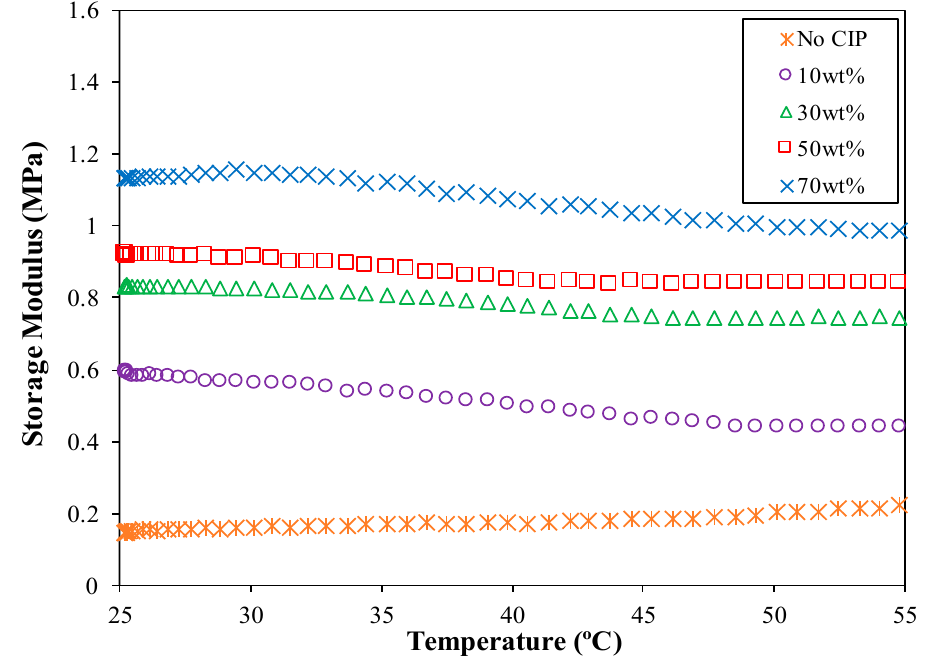
Figure 6. The influence of temperature on storage modulus of the ENR-based MREs at 1A for different CIPs content.